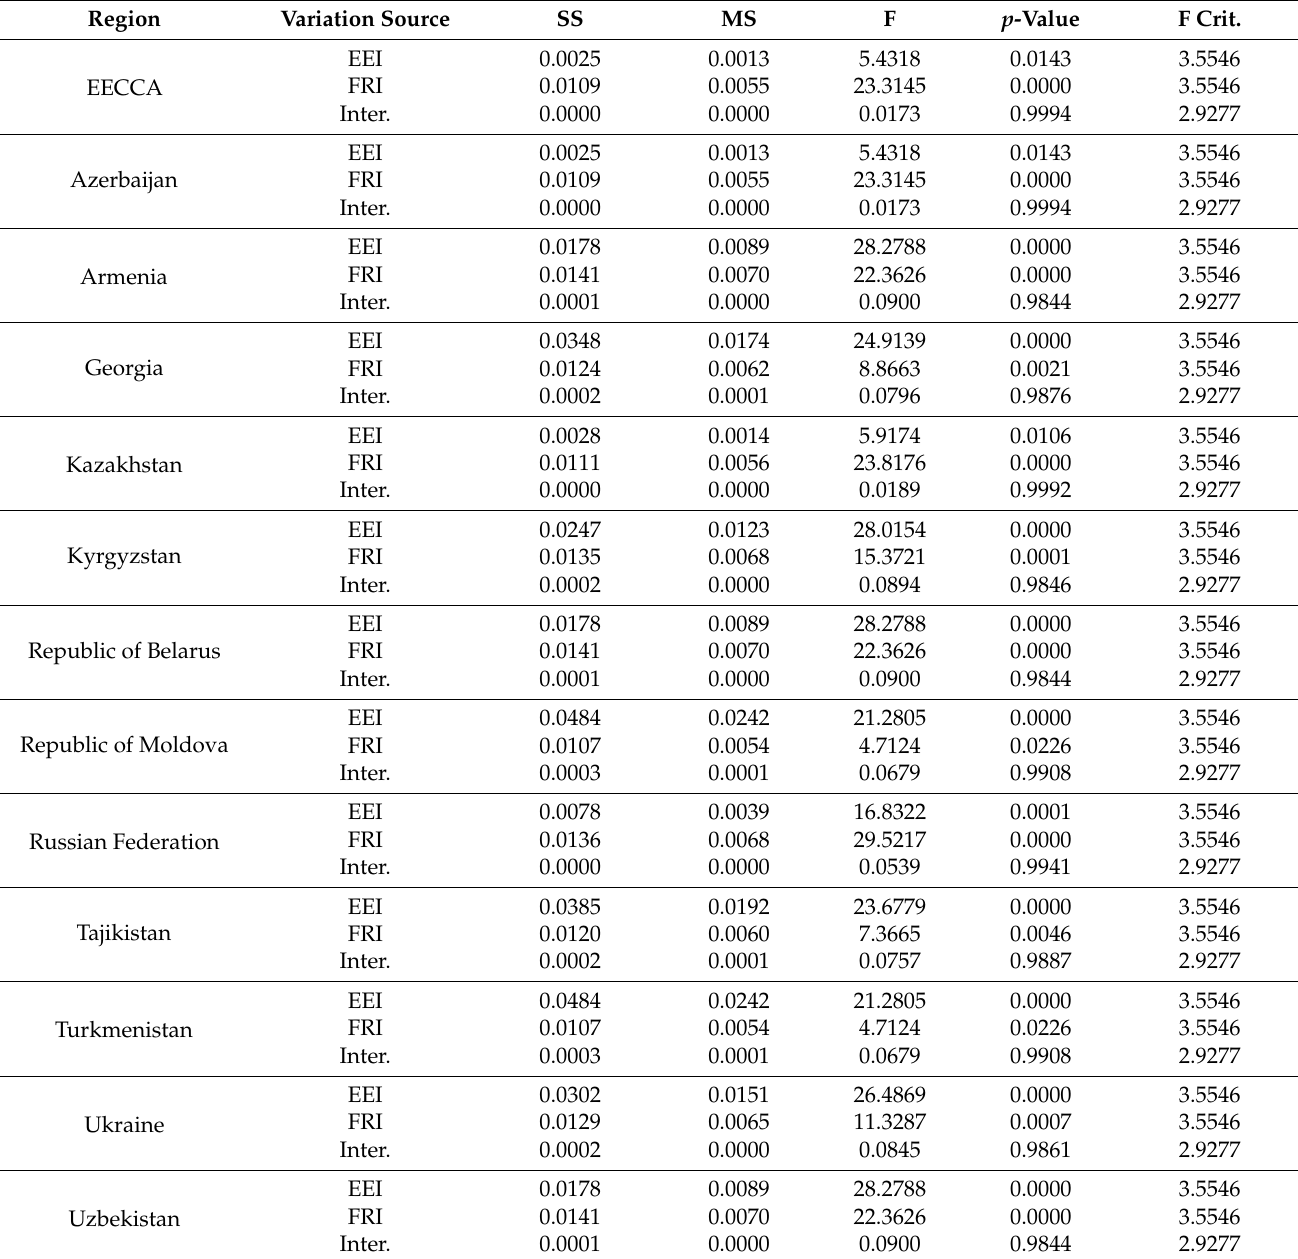
Table 2. The indicators of the influence of the factors under study on the level of energy supply to socially vulnerable groups of the population of the EECCA countries.